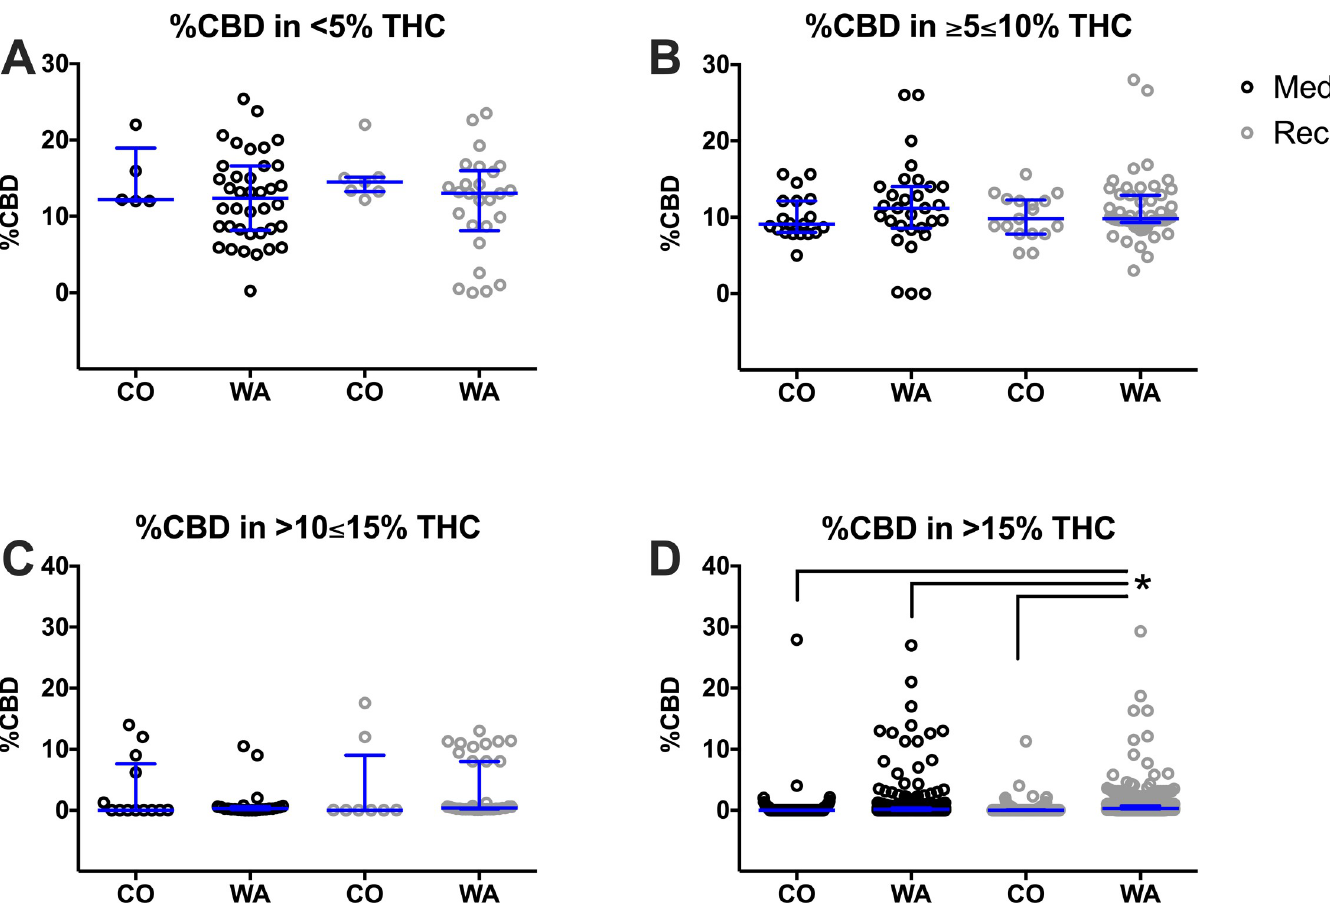
Fig 9. Percent CBD at different strength product categories based on THC content in CO and WA medicinal and recreational programs. Products are presented in the following categories: < 5% THC (A), � 5 � 10% THC (B), > 10 � 15% THC (C), and > 15% THC (D) in CO recreational or medicinal menus and WA recreational or medicinal dispensaries. Every herb cannabis product in the surveyed states and programs are plotted as open circles. Medicinal programs (Med; black circles) and recreational programs (Rec; grey circles) were compared. Data are presented as median with interquartile range. � P < 0.05 Recreational WA vs. Medicinal WA, Medicinal CO, and Recreational CO (linked line). One-way ANOVA and Tukey’s multiple comparison test. Descriptive statistics could be found in S11 Table.